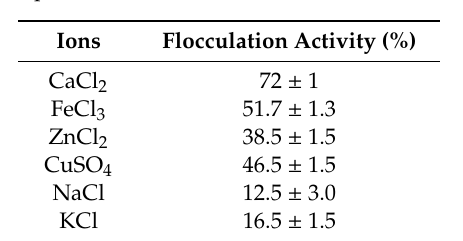
Table 2. Flocculation activity (%) of the extracted EPS in the presence of di ff erent ions. The numerical values indicate the means of replicates (n = 3) ± standard